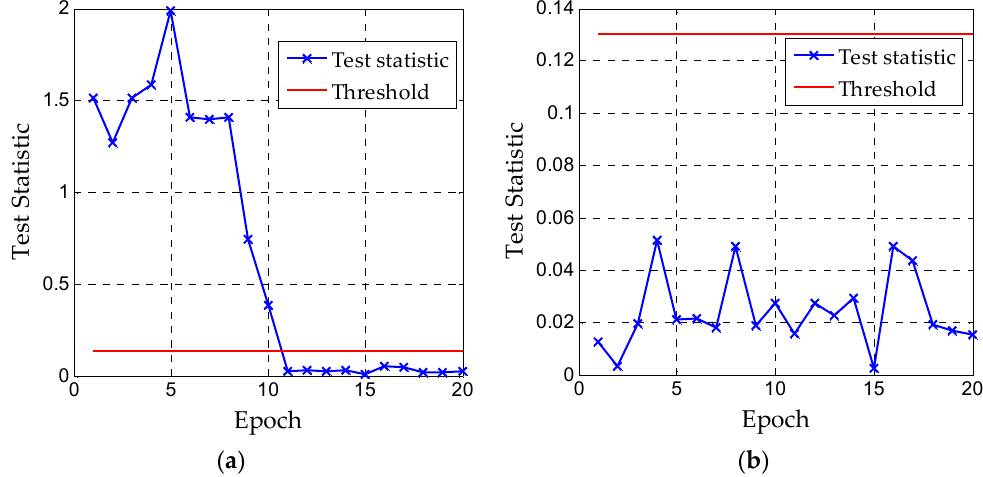
Figure 8. ( a ) CRAIM Test Statistic after Using Strategy 1, ( b ) CRAIM TestStatistic after Using Strategy